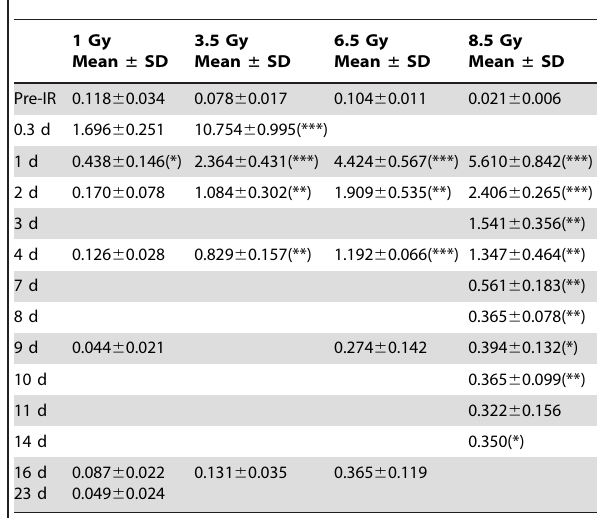
Table 2. Values for c -H2AX foci per cell in macaque lymphocytes after total body irradiation with doses of 1, 3.5, 6.5 and 8,5 Gy at the indicated times in days (d).